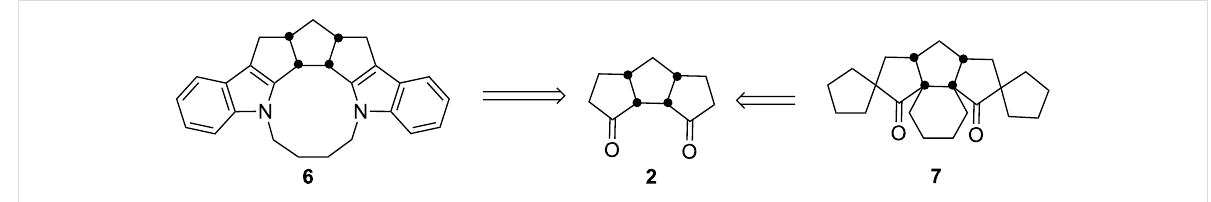
Figure 3: Retrosynthetic approach to aza-polyquinane 6 and spiro-polyquinane 7 .